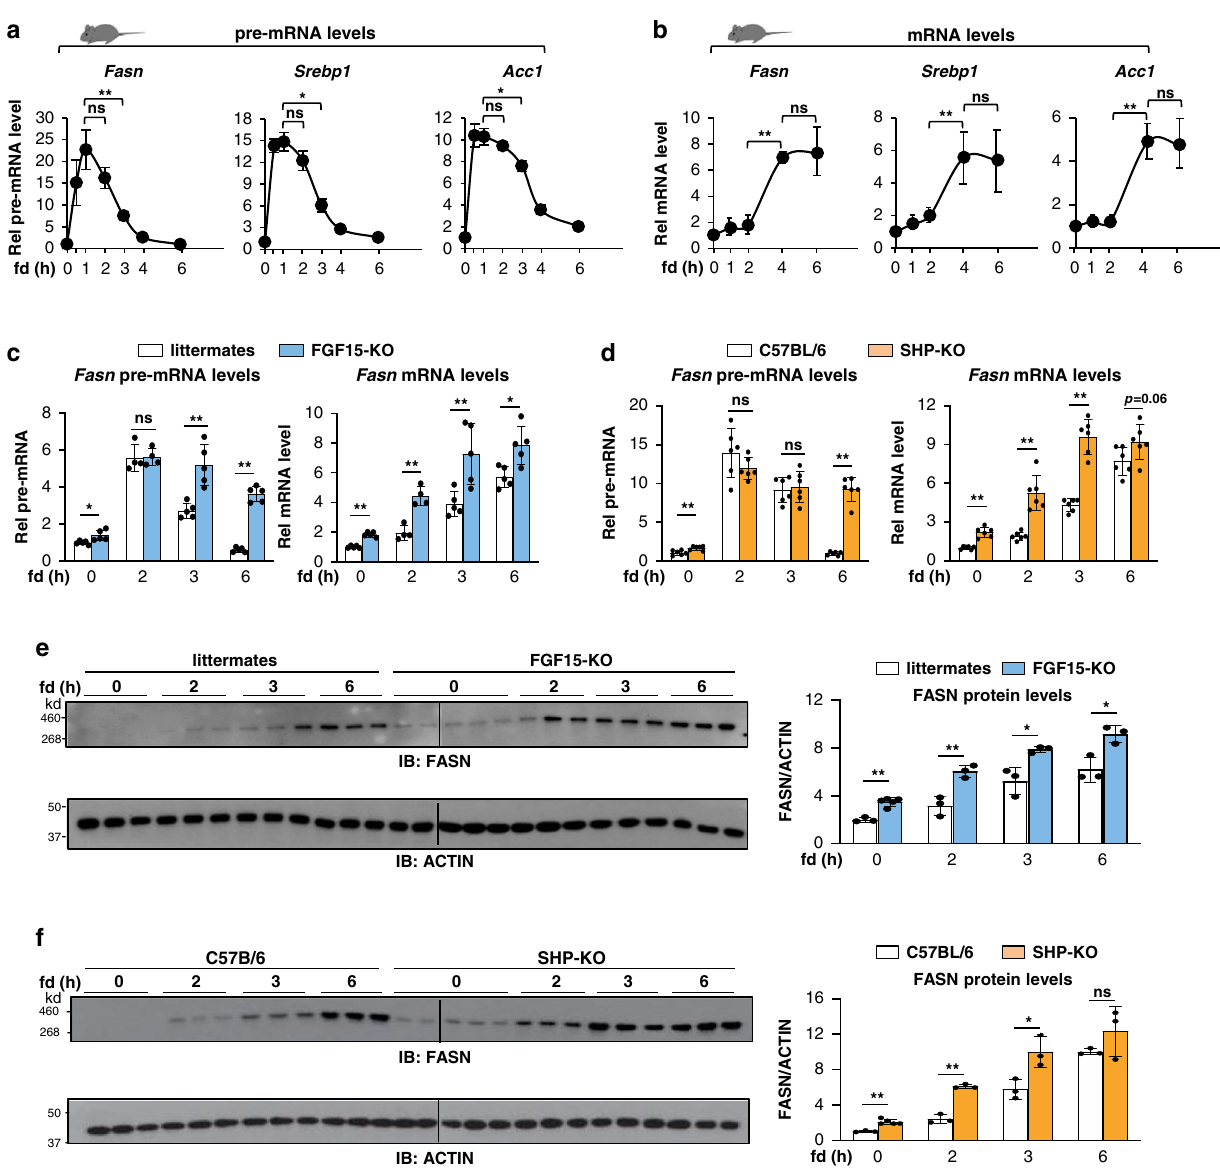
Fig. 1 Late fed-state transcriptional repression of lipogenic genes is dependent on both FGF15 and SHP. Mice were fasted overnight and refed normal chow for the indicated times. a Relative levels of pre-mRNAs of lipogenic genes in the livers of C57BL/6 mice measured by RT-qPCR using primers spanning the intron 1 and exon 1 boundaries and b mRNA levels of these genes. c – f Relative levels of hepatic Fasn pre-mRNA ( c , left), mRNA ( c , right), and protein ( e ) in FGF15-KO mice or control littermates. Relative levels of hepatic Fasn pre-mRNA ( d , left), mRNA ( d , right), and protein ( f ) in SHP-KO mice or control C57BL/6. Data presented as mean values ± Standard Deviation (SD) are shown ( a , b , n = 5 mice; c , n = 4 for 2 h, n = 5 for other times, mice; d , n = 6 mice; e , f , n = 5 for 0 time, FGF15-KO mice, n = 3 for other times, mice), and statistical signi fi cance was determined by ( a , b ) one-way ANOVA with the Tukey post-test or ( c – f ) two-tailed Student ’ s t -test. * P < 0.05, ** P < 0.01, ns, statistically not signi fi